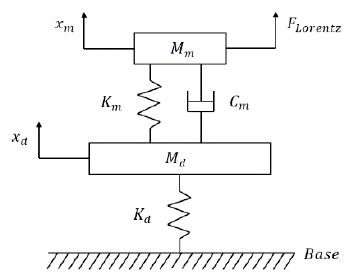
Figure 7. Diagram of the mechanical vibration system.